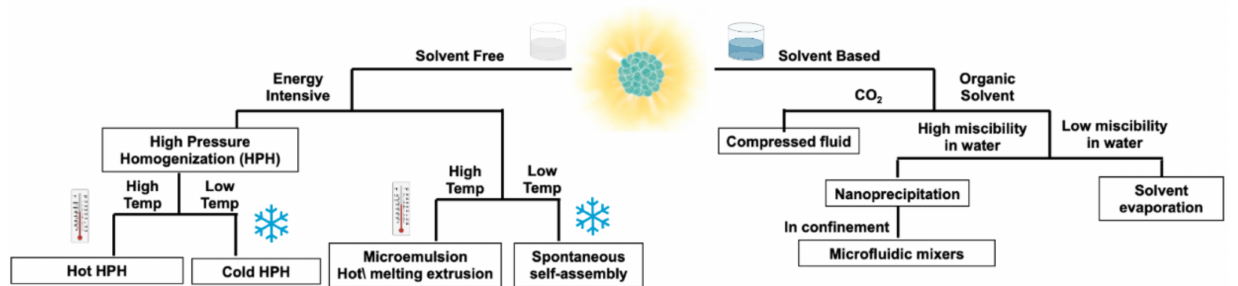
Figure 5. Main methods for FONs